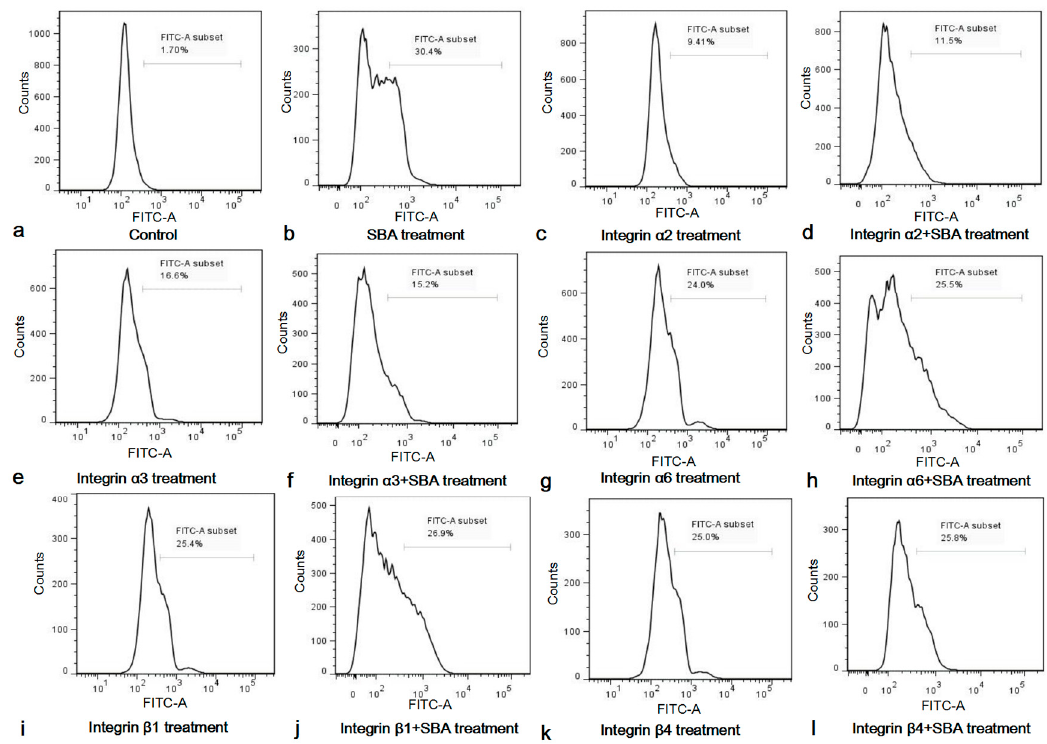
Figure 5. ( a – l ) Functions of integrin inhibitors on IPEC-J2 cell apoptosis and SCA. Cell apoptosis in different treatments for 24 h was determined by FCM and shown in ( a ) Control, 0.0 mg/mL SBA treatment; ( b ) 2.0 mg/mL SBA treatment; ( c ) α 2 inhibitor treatment; ( d ) α 2 inhibitor + 2.0 mg/mL SBA treatment; ( e ) α 3 inhibitor treatment; ( f ) α 3 inhibitor + 2.0 mg/mL SBA treatment; ( g ) α 6 inhibitor treatment; ( h ) α 6 inhibitor + 2.0 mg/mL SBA treatment; ( i ) β 1 inhibitor treatment; ( j ) β 1 inhibitor treatment + 2.0 mg/mL SBA treatment; ( k ) β 4 inhibitor treatment; ( l ) β 4 inhibitor treatment